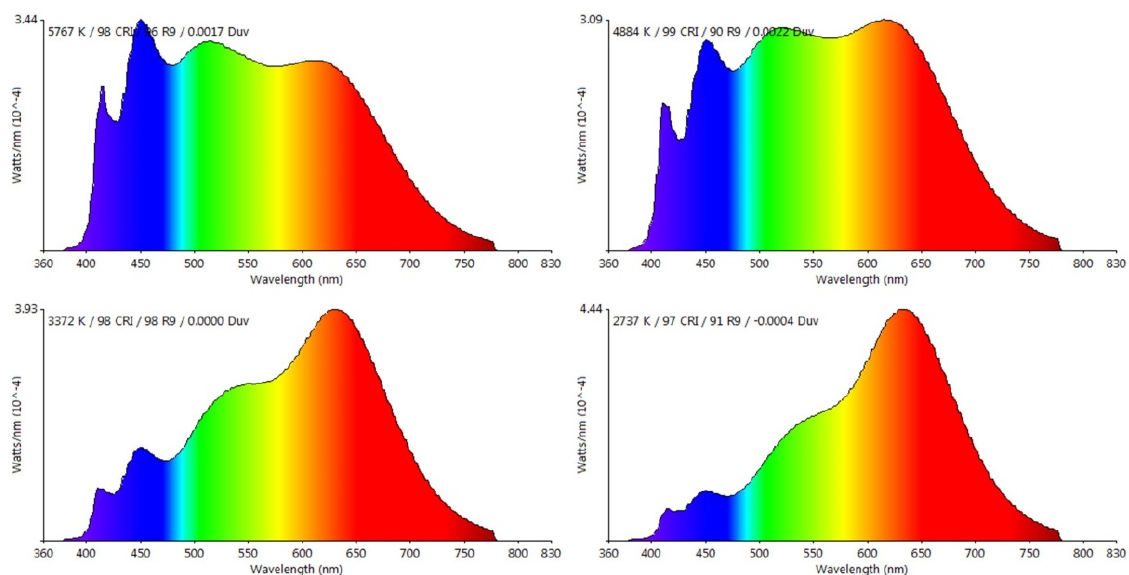
Figure 8. Spectral power distribution corresponding to the four selected LEDs. OsramColorCalculator was used to plot the SPDs.